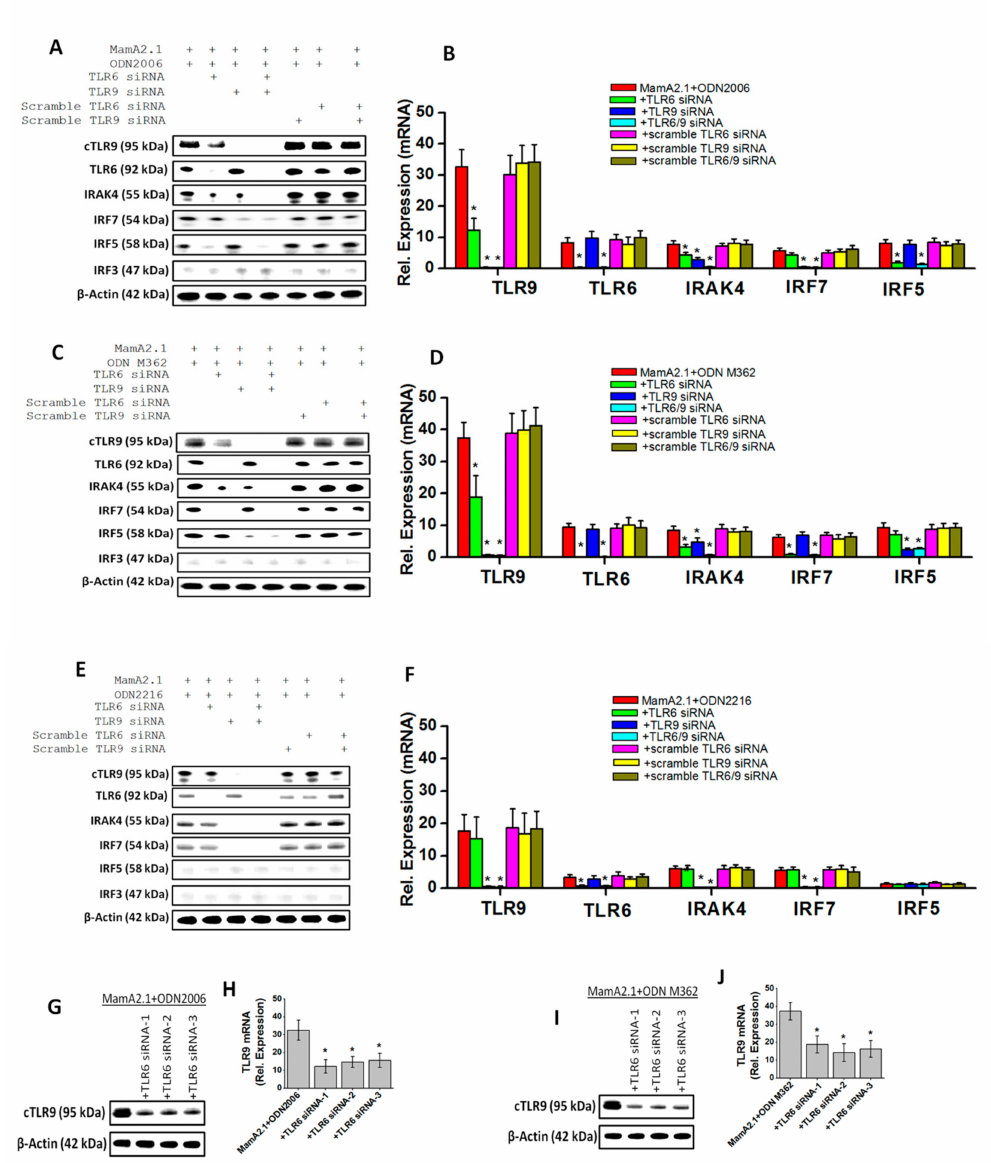
Figure 5. Interplay of TLR-6 / -9 signaling in THP-1 cells following treatment with ODN2006 and M362. Protein expression and densitometry analysis of TLR-6 / -9 proteins and their downstream signaling factors, namely IRAK4, IRF7, IRF5, and IRF3, following treatment with ODN2006 ( A , B ), ODN M362 ( C , D ), and ODN2216 ( E , F ). As TLR-6 siRNA treatment induced decreased expression of TLR-9 ( A – D ), we checked if this could be due to o ff -target e ff ects. However, as shown in ( G – J ), three di ff erent TLR-6 siRNAs induced the decreased expression of TLR-9, suggesting interplay between TLR-6 and -9 expression. All experiments were performed in four independent replicates, and data are expressed as mean ± SD, * p < 0.05 compared with the MamA2.1 peptide treatment